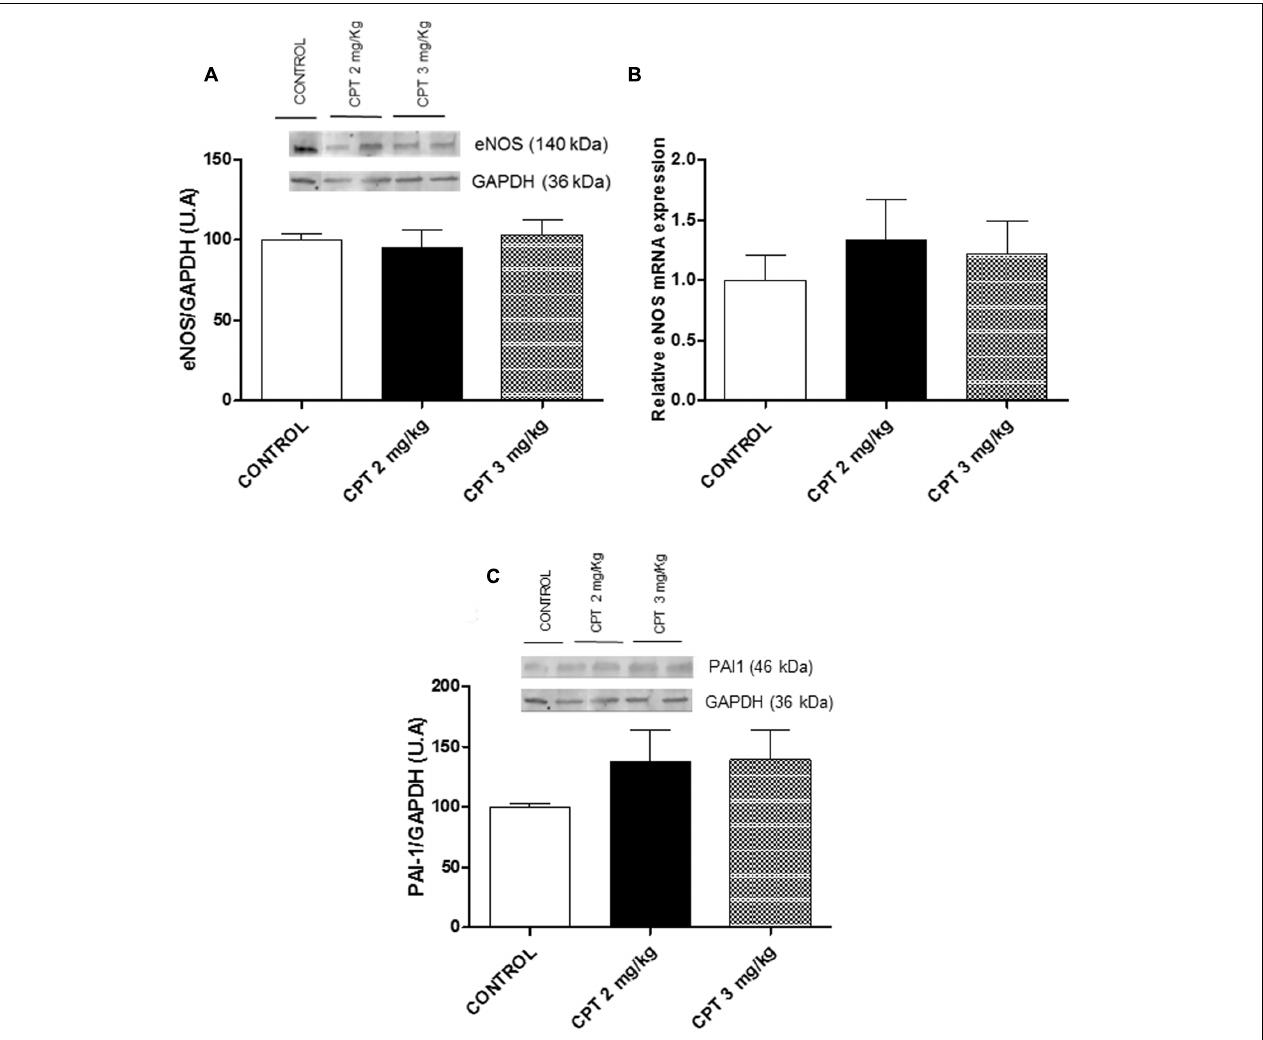
FIGURE 9 | (A) Representative immunoblots for eNOS protein expression in aorta. Diagram bars show the result of densitometric analysis of eNOS in aorta. (B) Quantitative analysis of eNOS mRNA levels in aorta. (C) Representative immunoblots for plasminogen activator inhibitor-1 (PAI-1) protein expression in aorta. Diagram bars show the result of densitometric analysis of PAI-1 in aorta. Data are presented as means ± SEM of observations obtained for 5–8 tissue samples from 5 to 8 animals per treatment. A one-way ANOVA followed by Bonferroni/Dunn post hoc test was used for statistical